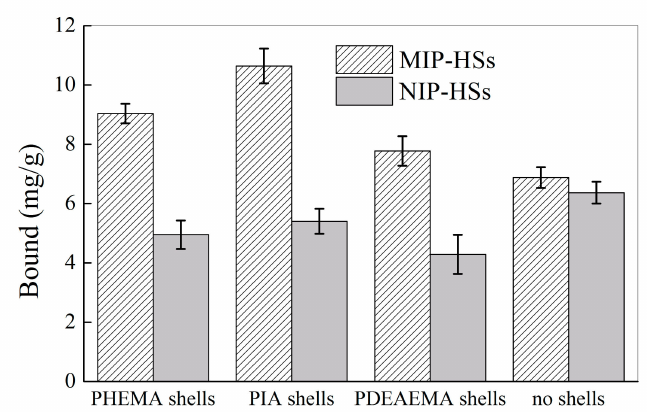
Figure 10. Equilibrium binding of the MIP-HSs and NIP-HSs nanospheres toward harmine (20 mg/L) in water.